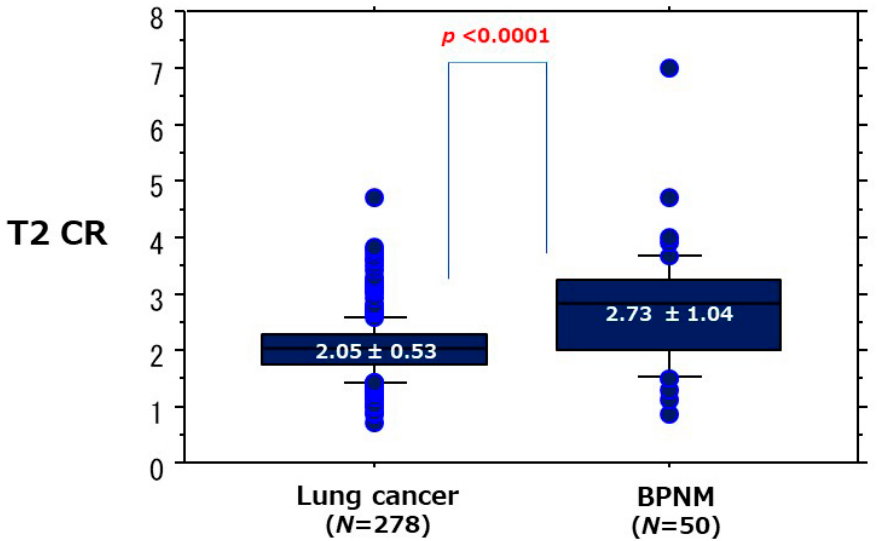
Figure 12. Relationships between the mean T2 CR and lung cancer/BPNM. The mean T2 CR (2.05 ± 0.53) of lung cancer was significantly lower than that (2.73 ± 1.04) of BPNM ( p < 0.0001).